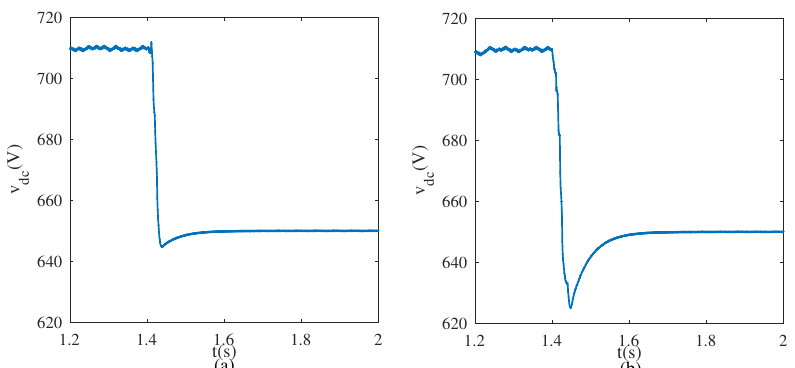
Figure 13. Comparison results of feedforward unit under condition of irradiation sudden decrease. ( a ) With a feedforward unit and ( b ) without a feedforward unit.